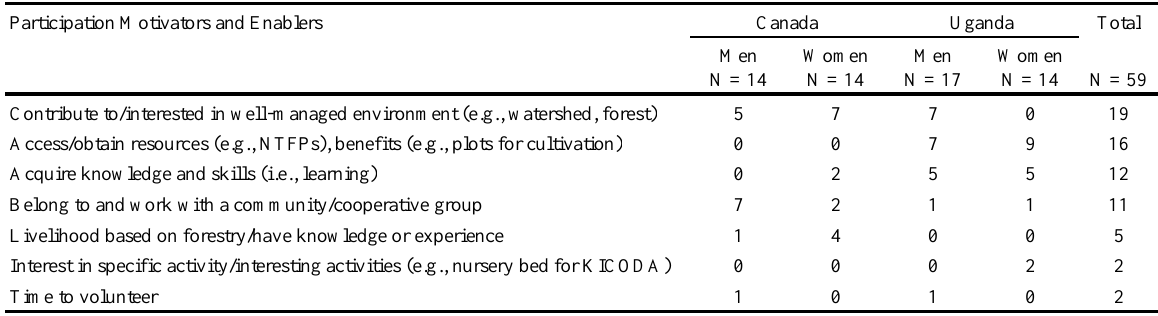
Table 4. Participation motivators and enablers identified by interviewees.